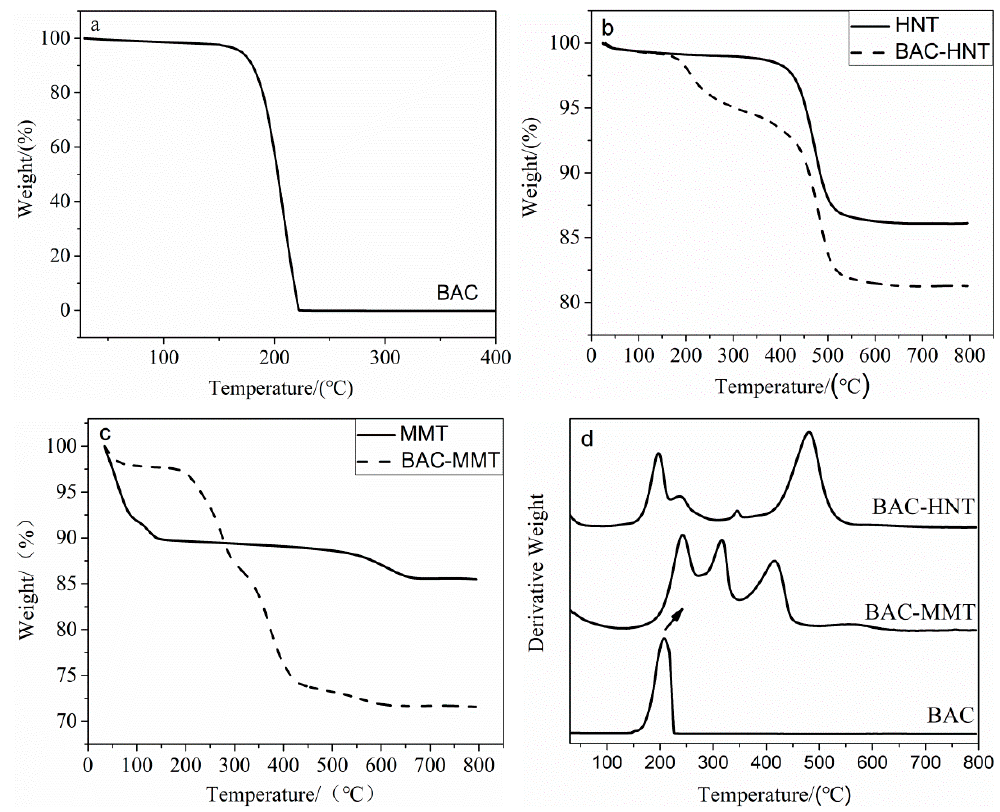
Figure 3. Thermogravimetric analysis: Thermal decomposition curves of ( a ) BAC, ( b ) HNT, and ( c ) MMT; ( d ) derivative thermal